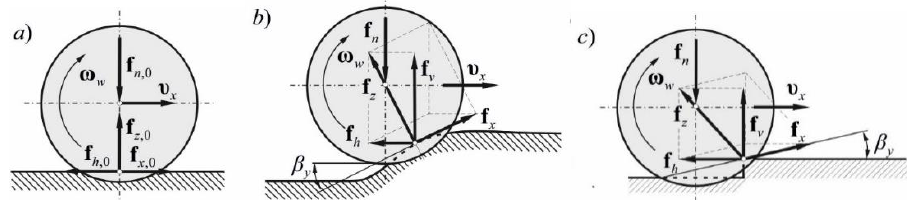
Figure 2. Diagram of a wheel load formation when overcoming road unevenness ( a ) flat road, ( b ) road unevenness, ( c ) step obstacle.